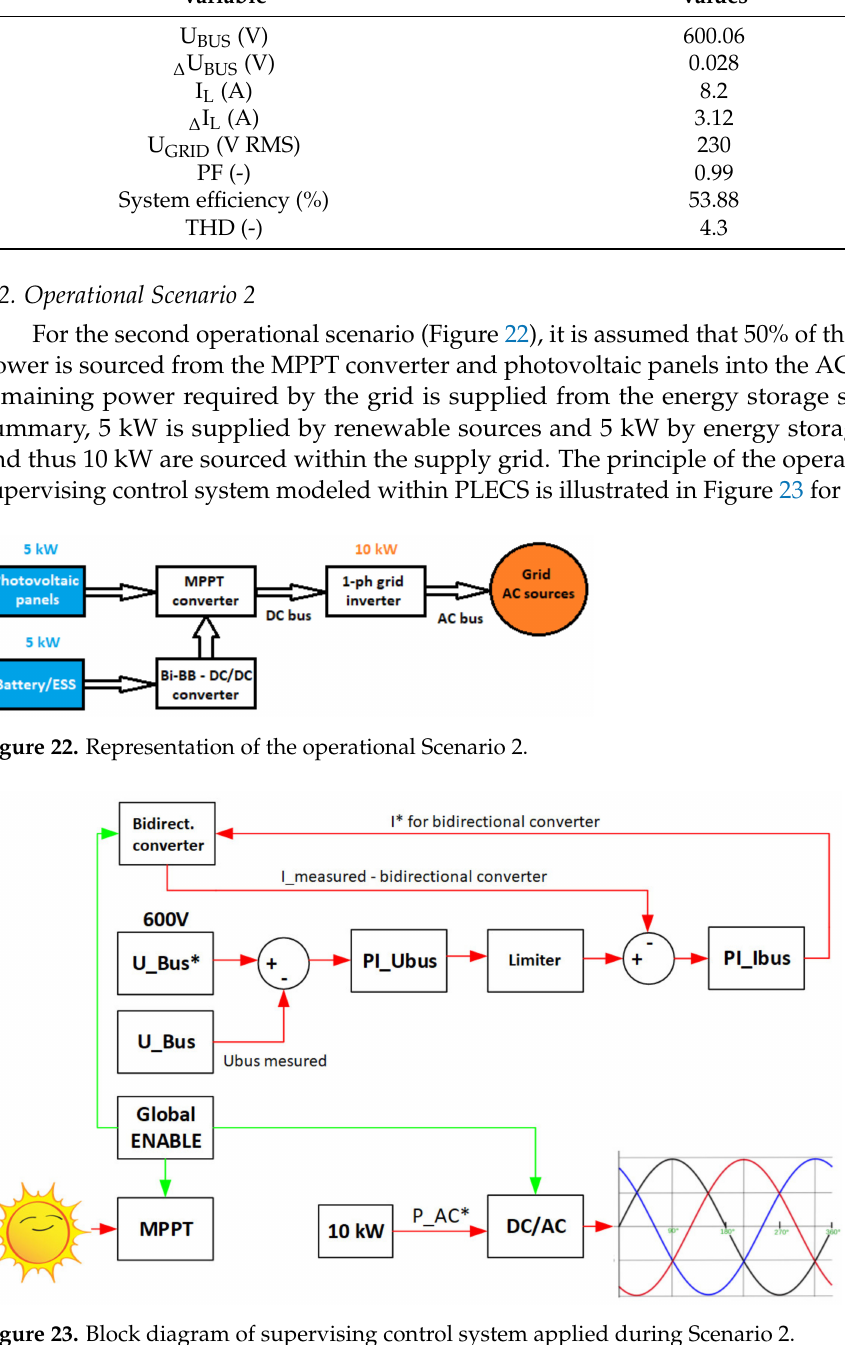
Figure 23. Block diagram of supervising control system applied during Scenario